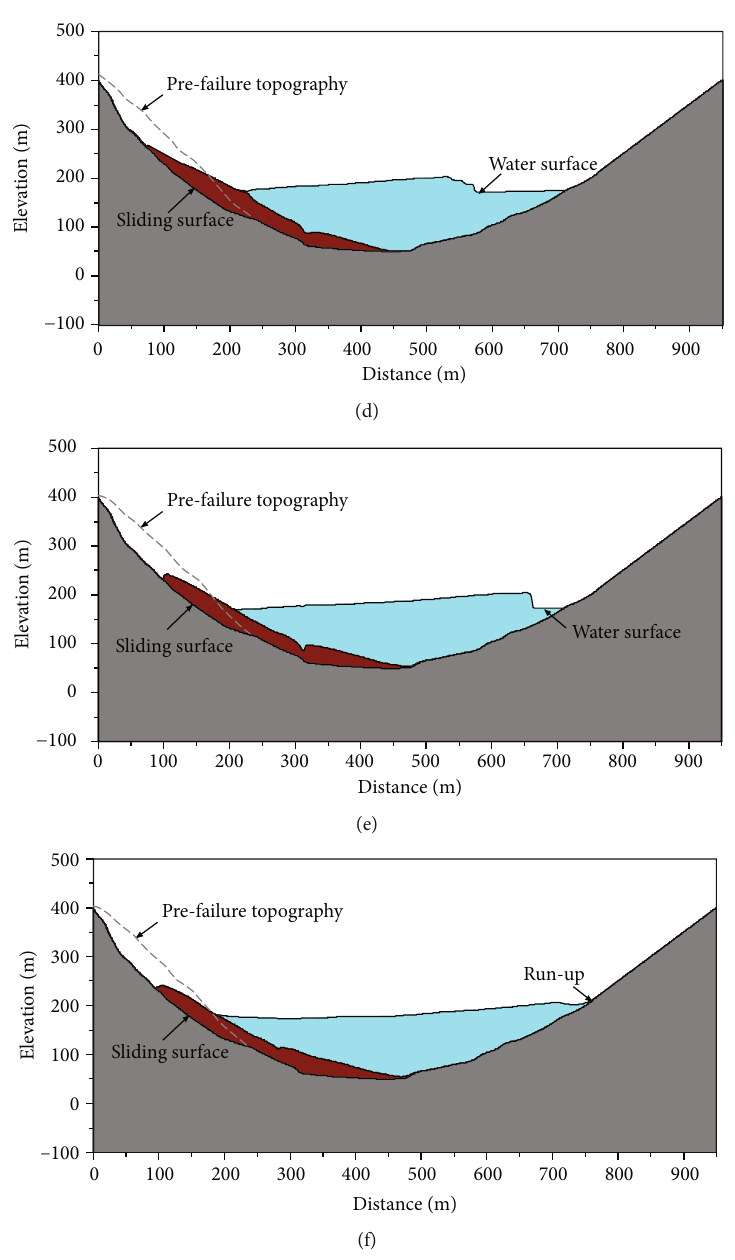
Figure 7: Numerical results of the disaster chain caused by the Gongjiafang landslide. (a) t = 3 s . (b) t = 6s . (c) t = 9 s . (d) t = 12 s . (e) t = 15 s . (f) t = 18 s